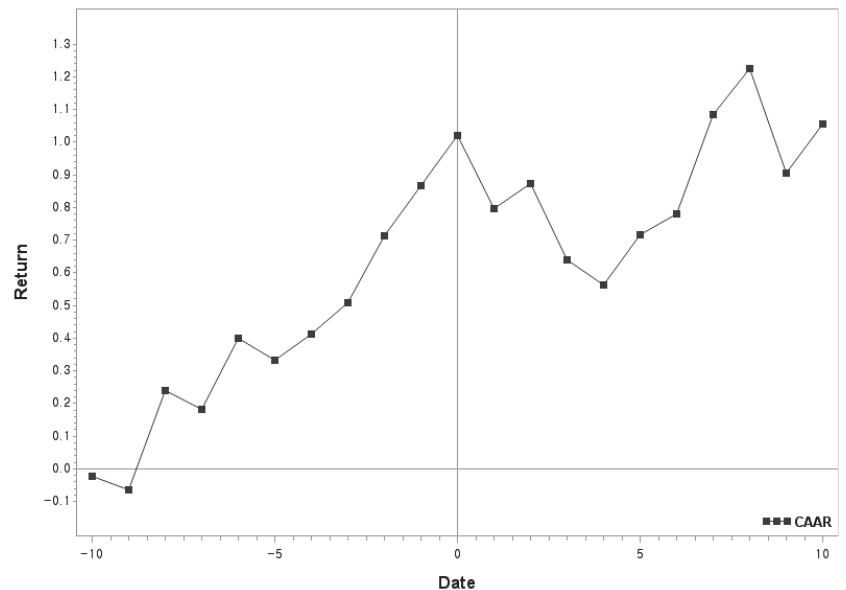
<Figure 4> CAAR for ± 10 Days from Announcement of a Celebrity Endorsement Contract of Marketing-focused